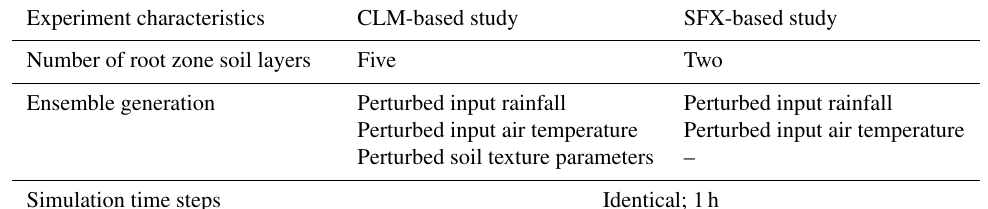
Table 2. Similarities and differences between the two quasi-identical assimilation